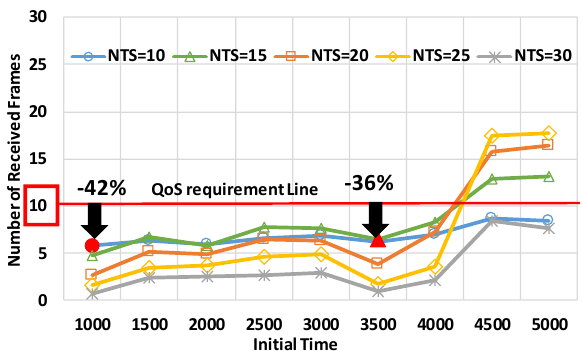
Figure 12. The number of received frames in the medium intersection.